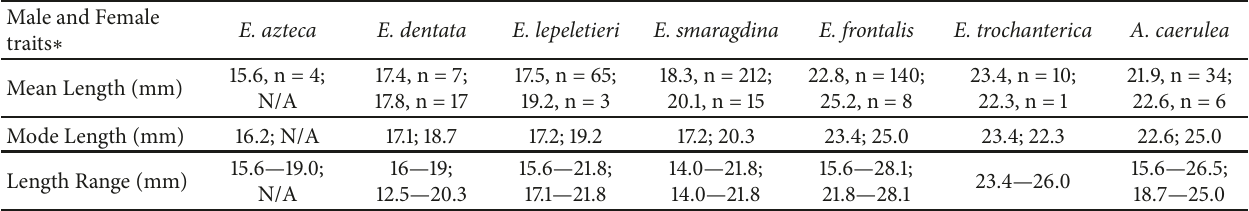
Table 1: Size in male and female parasitic euglossines, Aglae and Exaerete . Sample areas were Brazil, Panama, Suriname, FrenchGuiana, Peru, Ecuador, Costa Rica, Mexico, Trinidad, Venezuela and Colombia. ∗ Males given first in Table cells.